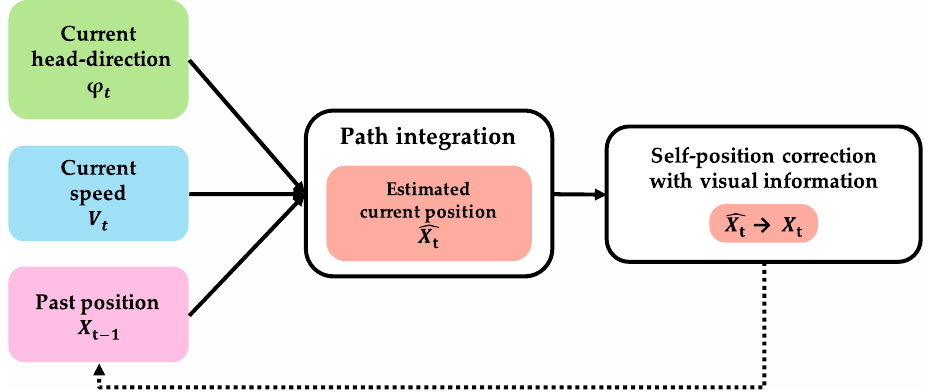
Figure 6. Algorithm of path integration to calculate current position. When initial-position information and movement information are input, position information after movement ( ˆ X t ) is calculated using grid cells. The region where path integration is performed requires input of head-direction information ( ϕ t ) and speed information ( V t ) as movement information, and past position at one theta cycle before ( X t − 1 ) as initial-position information. To perform self-position correction with visual information, the region that performs path integration outputs result of path integration ( ˆ X t ) to region that performs self-position correction with visual information. Corrected position information is assumed to be the initial-position information for the next path integration. This assumption insists that there is a loop structure that inputs correction result ( X t ) as initial-position information from the region where self-position correction with visual information is performed to the region where path integration is